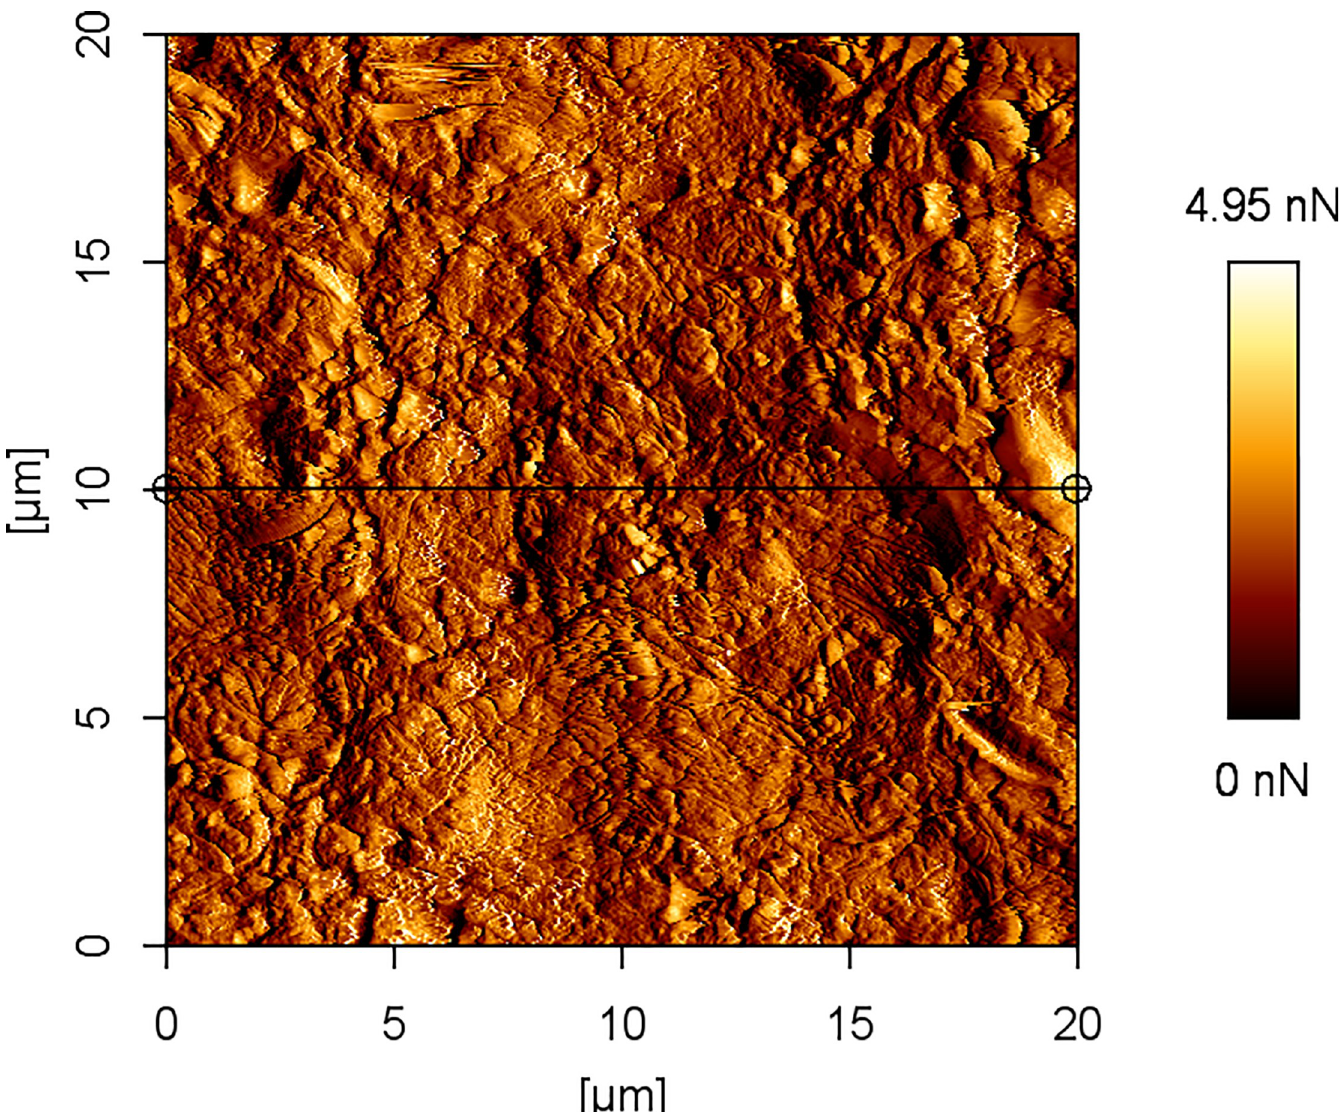
Fig 3. Example image of corneal surface treated with FS1 with AFM vertical